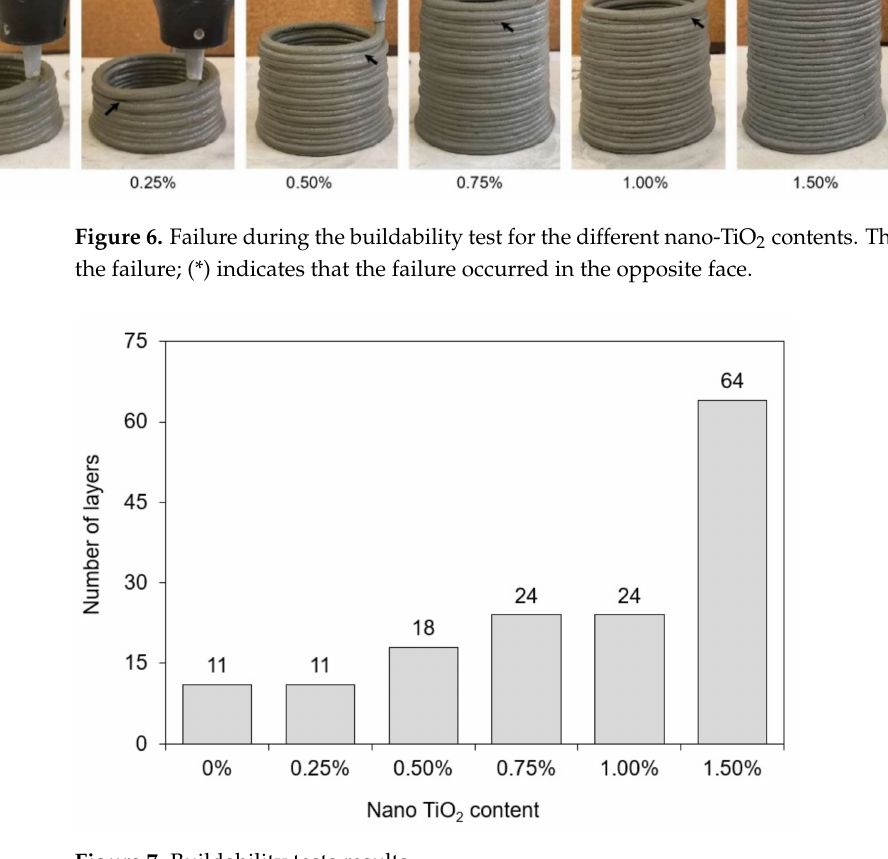
Figure 7. Buildability tests